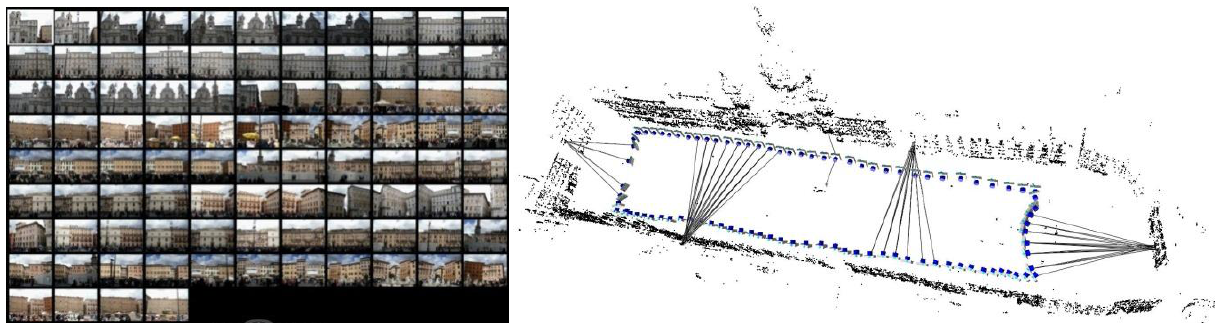
Figure 7. Automated recovery of camera poses and sparse point cloud for a long terrestrial image sequence